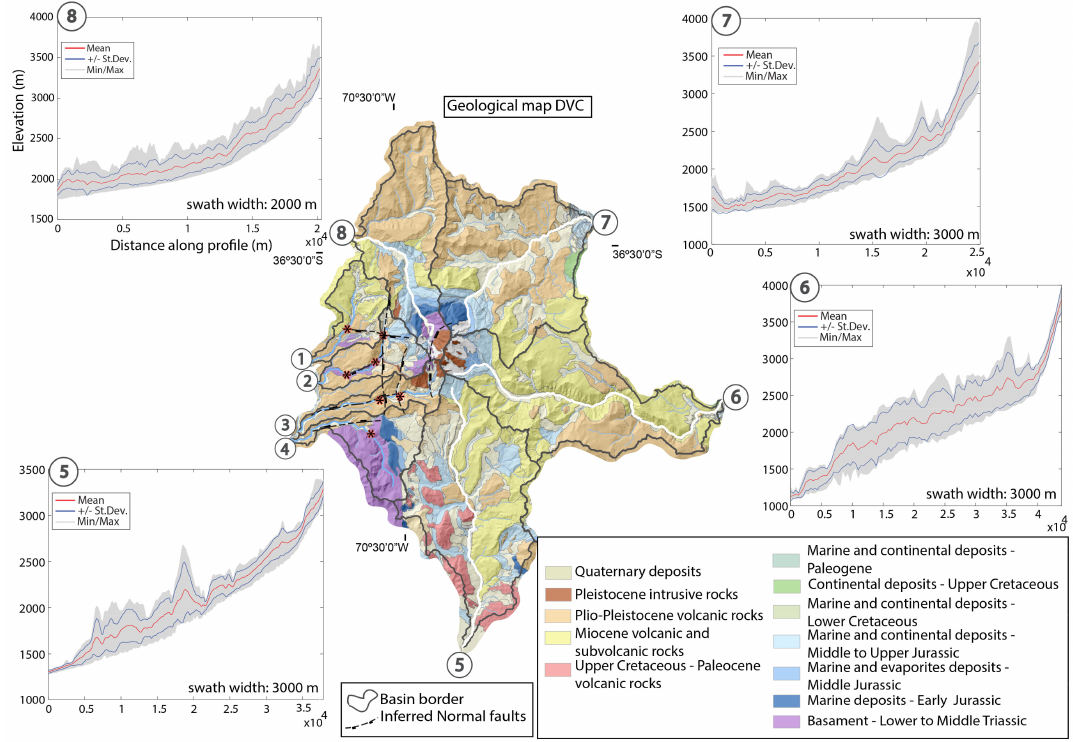
Figure A5. Geologic map of the Domuyo Volcanic Center (DVC). The topographic swath profiles 5–8 correspond to numbered rivers marked in white in the map. The rivers 1–4 are located where the magmatic products cover the area homogeneously and no major compositional changes